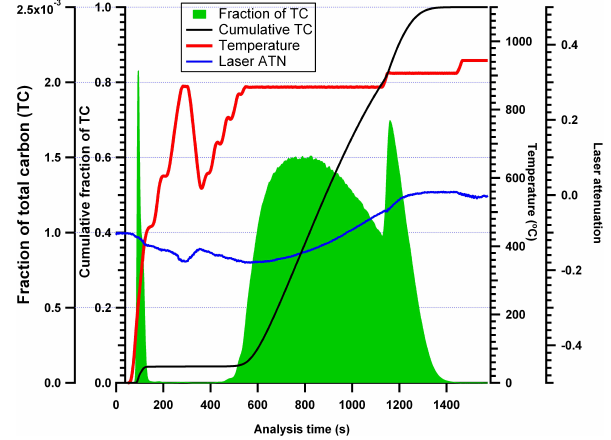
Fig. 5. This graph shows a typical time evolution of carbon that evolves from ECRM sample (GTS-6) during the thermal/optical process. The shaded green curve shows the fraction of total car- bon (TC) that is released as the sample is heated. The cumulative percent of TC is shown in the black curve. The temperature history is given in red and the attenuation of the laser transmitted through the sample filter is given in blue.